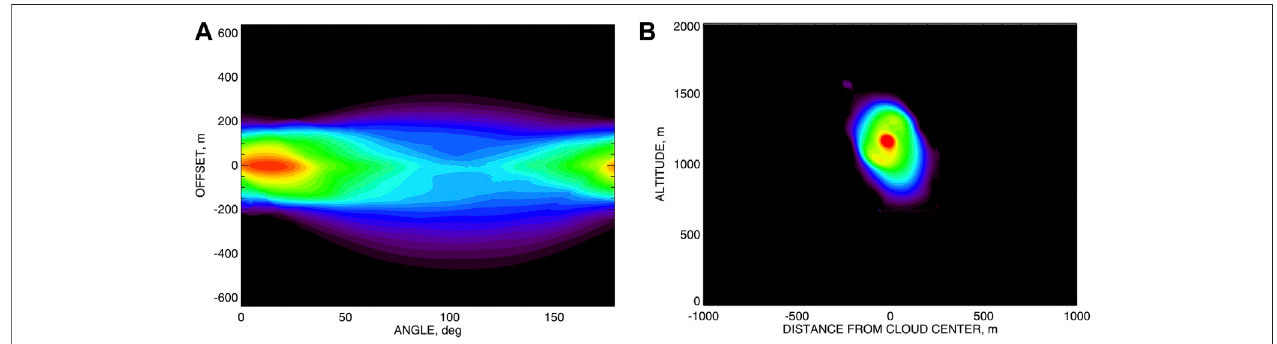
FIGURE8|(A) TheCOTtomogram τ tom ( ψ , ρ )derivedfrom R tom and L tom ( Figure7 )usingtheproxyrelation Eq.9 (theunitsareirrelevantsonocolorbarisshown). (B) The spatial distribution of the extinction coef fi cient derived from τ tom using inverse Radon transform and calibrated by the initial LES COT.